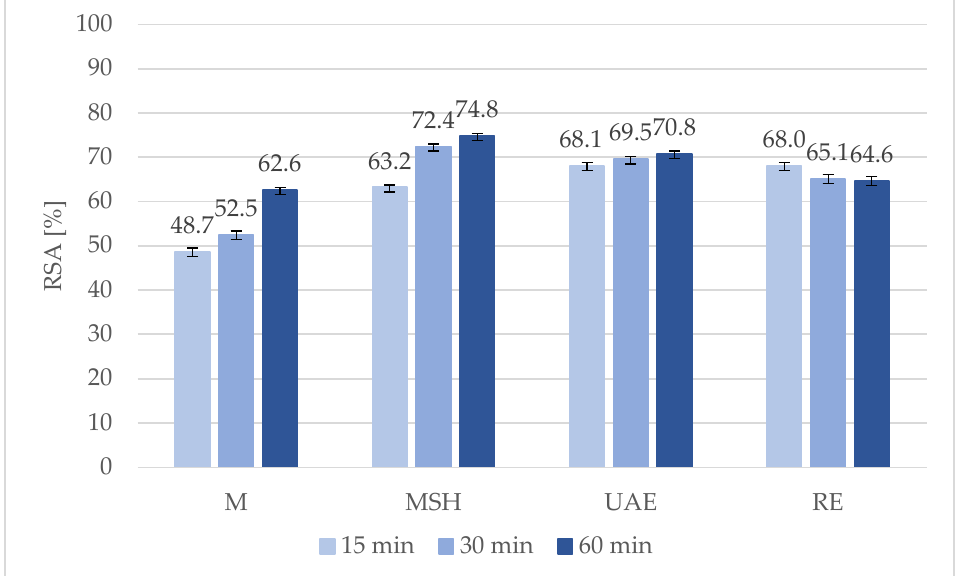
Figure 2. In fl uence of extraction technique and conditions on DPPH radical scavenging activity of maca extracts obtained using water as the solvent (M—maceration; MSH—maceration with shak- ing; UAE—ultrasound-assisted extraction; RE—re fl ux extraction).